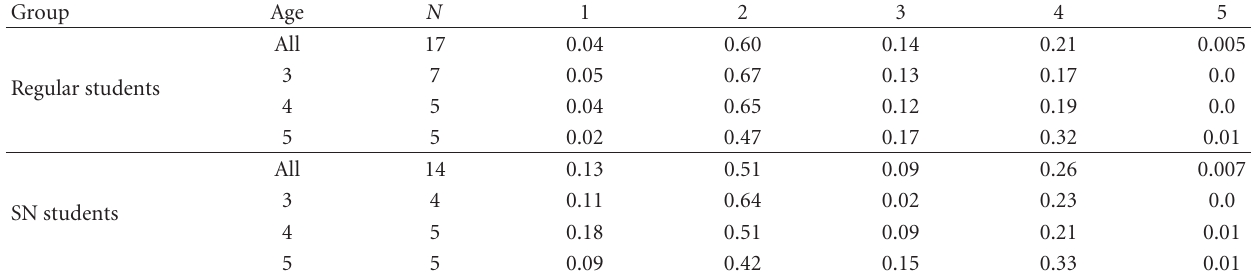
Table 3: Proportions of correct answers per level of understanding (the number of correct answers for each level divided by the total number of correct answers of each (age)